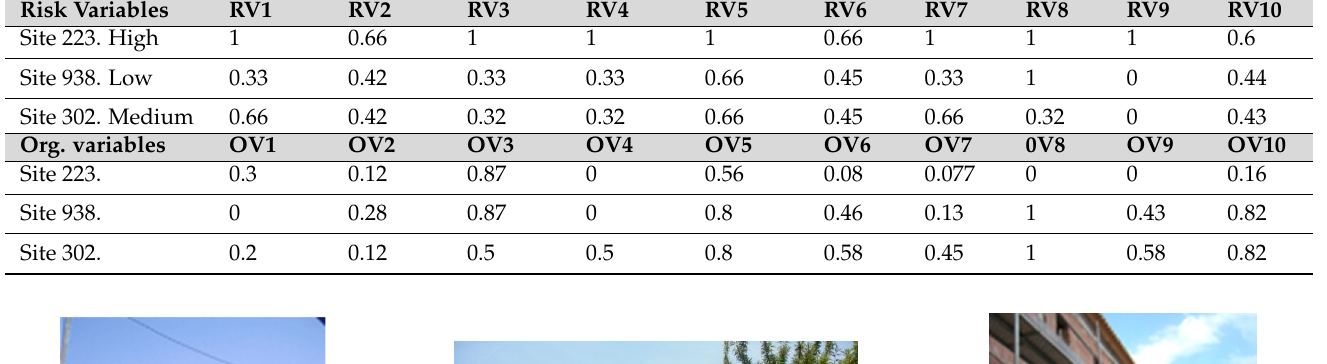
Table 3. Risk and organizational variables for three different construction sites selected by risk level.